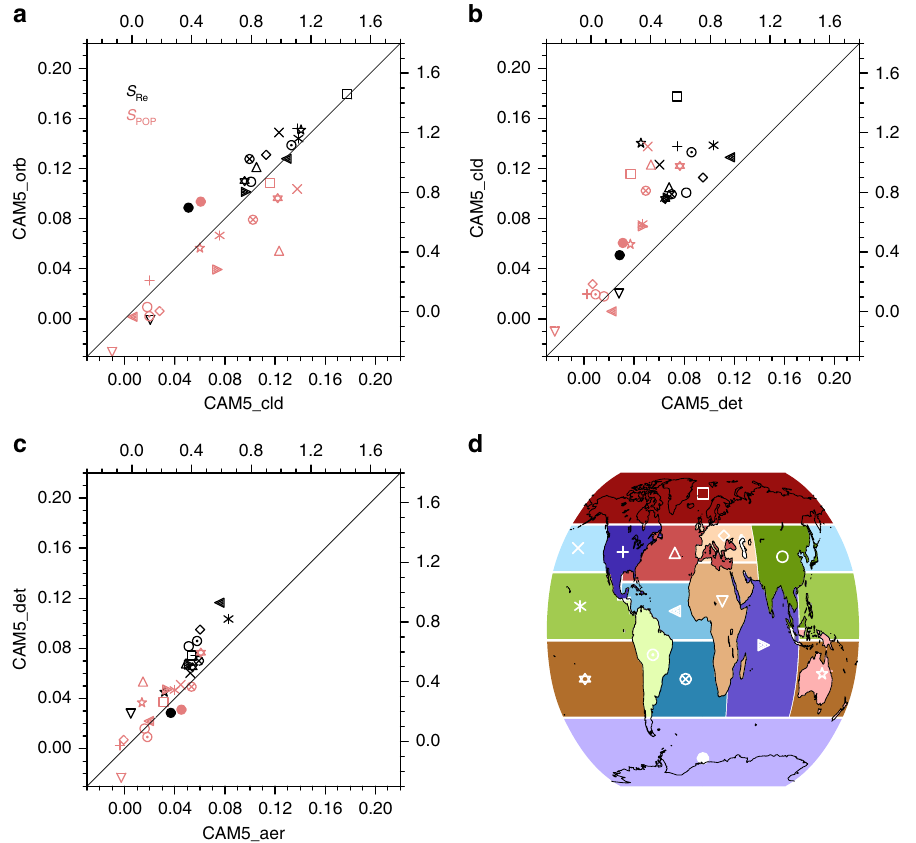
Fig. 3 Model regional mean susceptibility of cloud droplet size and susceptibility of precipitation probability as a function of retrieval procedure. Susceptibility comparisons between a CAM5_orb and CAM5_cld, b CAM5_cld and CAM5_det, and c CAM5_det and CAM5_aer are shown. Geographical regions are de fi ned in d . In a – c , S Re estimates are presented on the left and bottom axes and S POP estimates are presented on the right and top